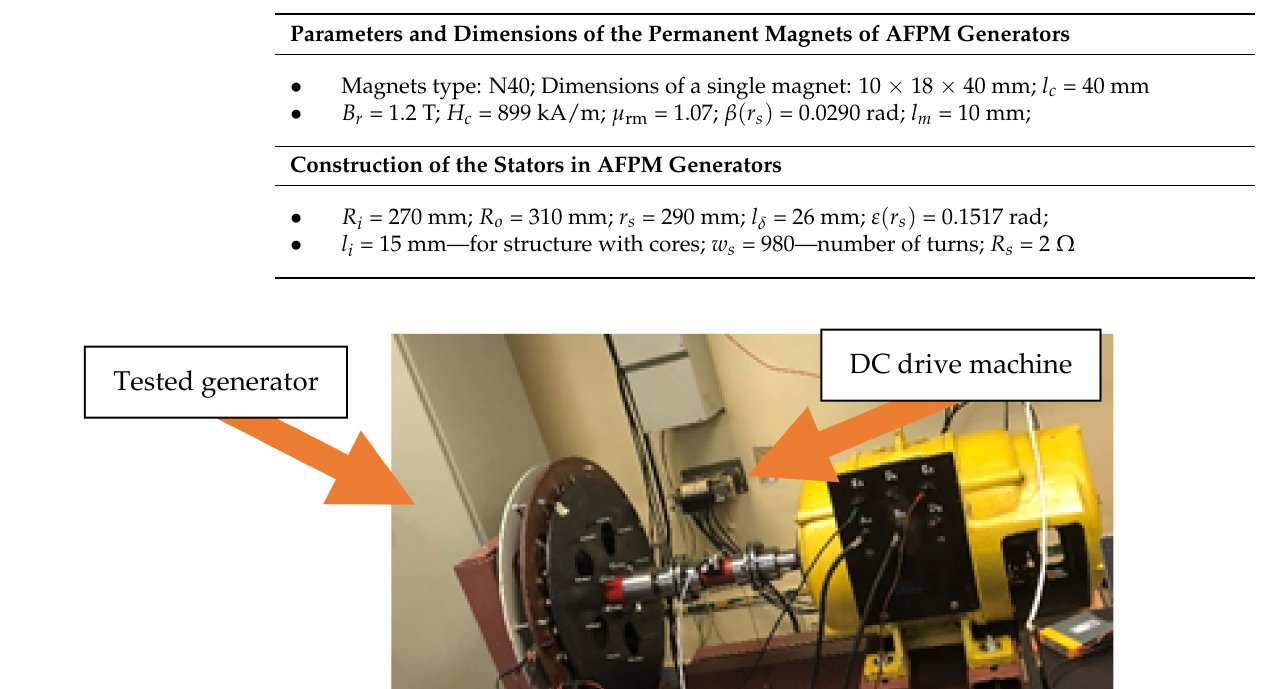
Figure 3. AFPM generator model with the ANSYS Maxwell program: ( a ) stator disc; ( b ) a rotor disc with PM arrangement; ( c ) assembling. Table 1. Design AFPMG data according to Figure 2.